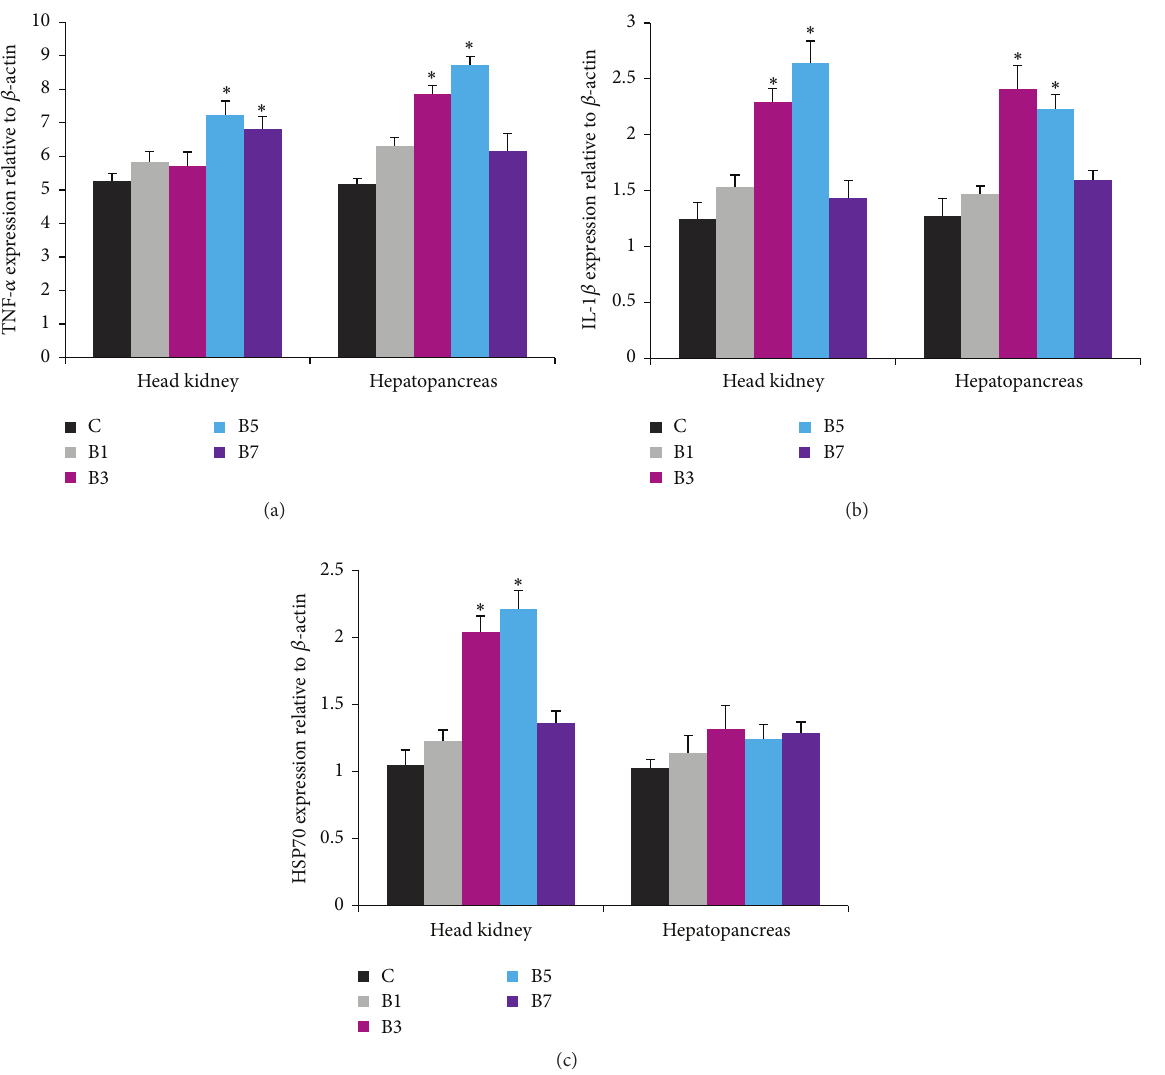
Figure 1: Relative mRNA expressions of upregulated genes ( TNF- 𝛼 , IL-1 𝛽 , and HSP70 ) in the head kidney and hepatopancreas of Labeo rohita fed banana peel flour (BPF) supplemented diets. A significant difference is denoted by an asterisk ( 𝑃 < 0.05 ). Each bar represents mean ± SEM ( 𝑛 = 9